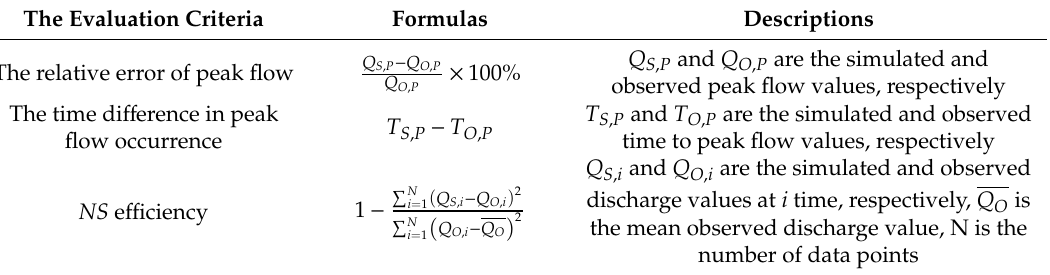
Table 2. The evaluation criteria of model performance. NS : Nash–Sutcli ff e.